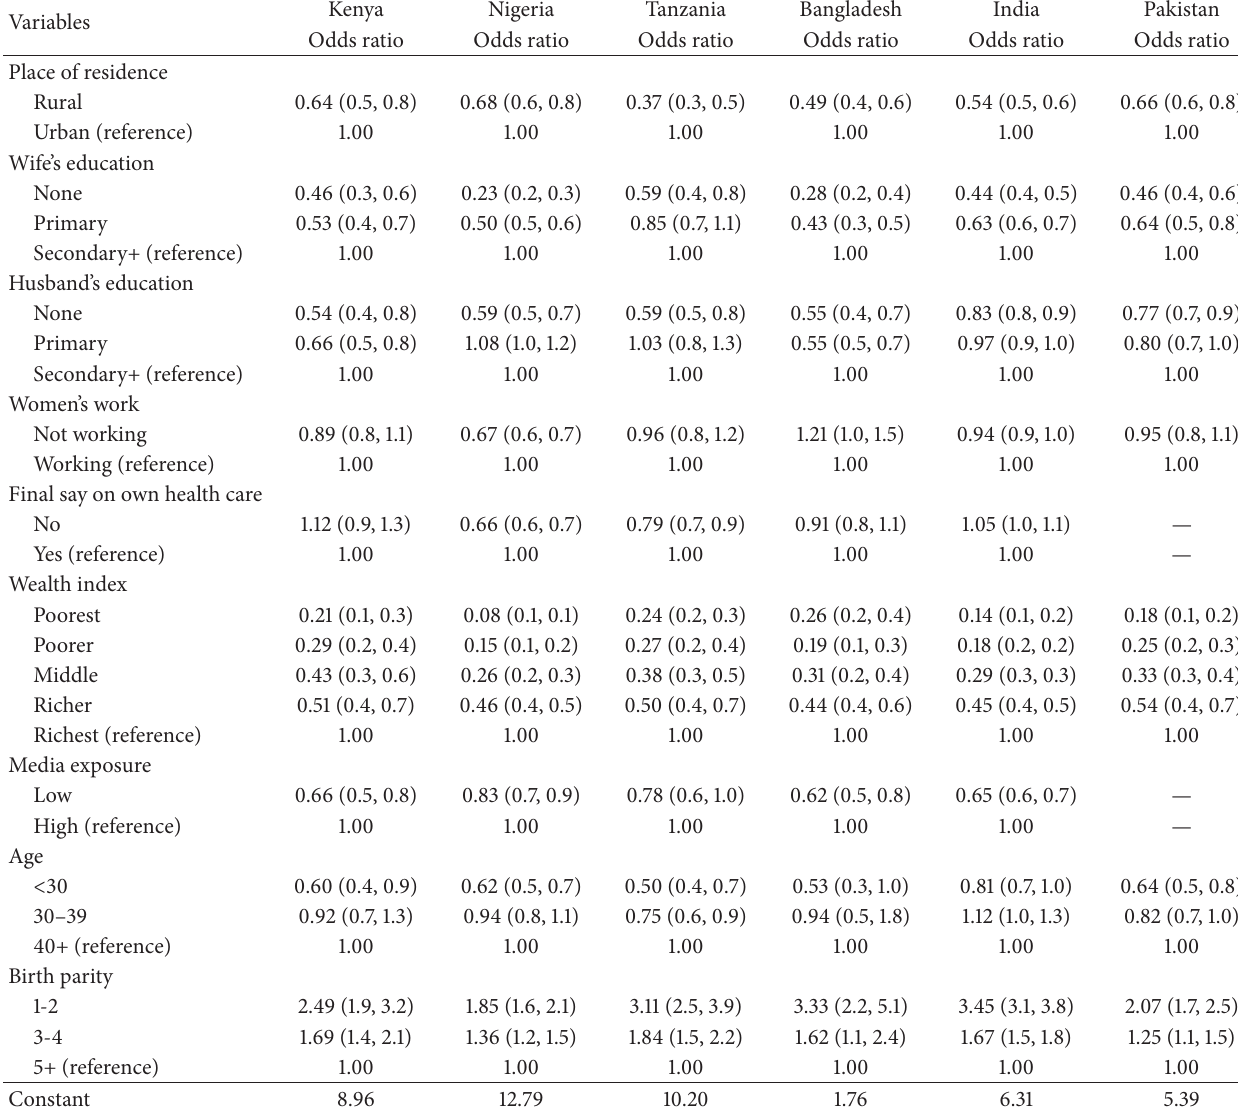
Table 3: Logistic regression on “using trained personnel in the past 5 years” by selected